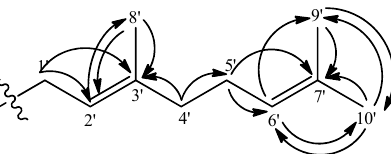
Figure 5. The geranyl moiety and its long-range Heteroatom Correlations.